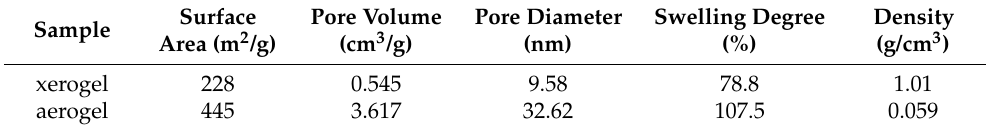
Table 1. Properties of the xerogel and aerogel.